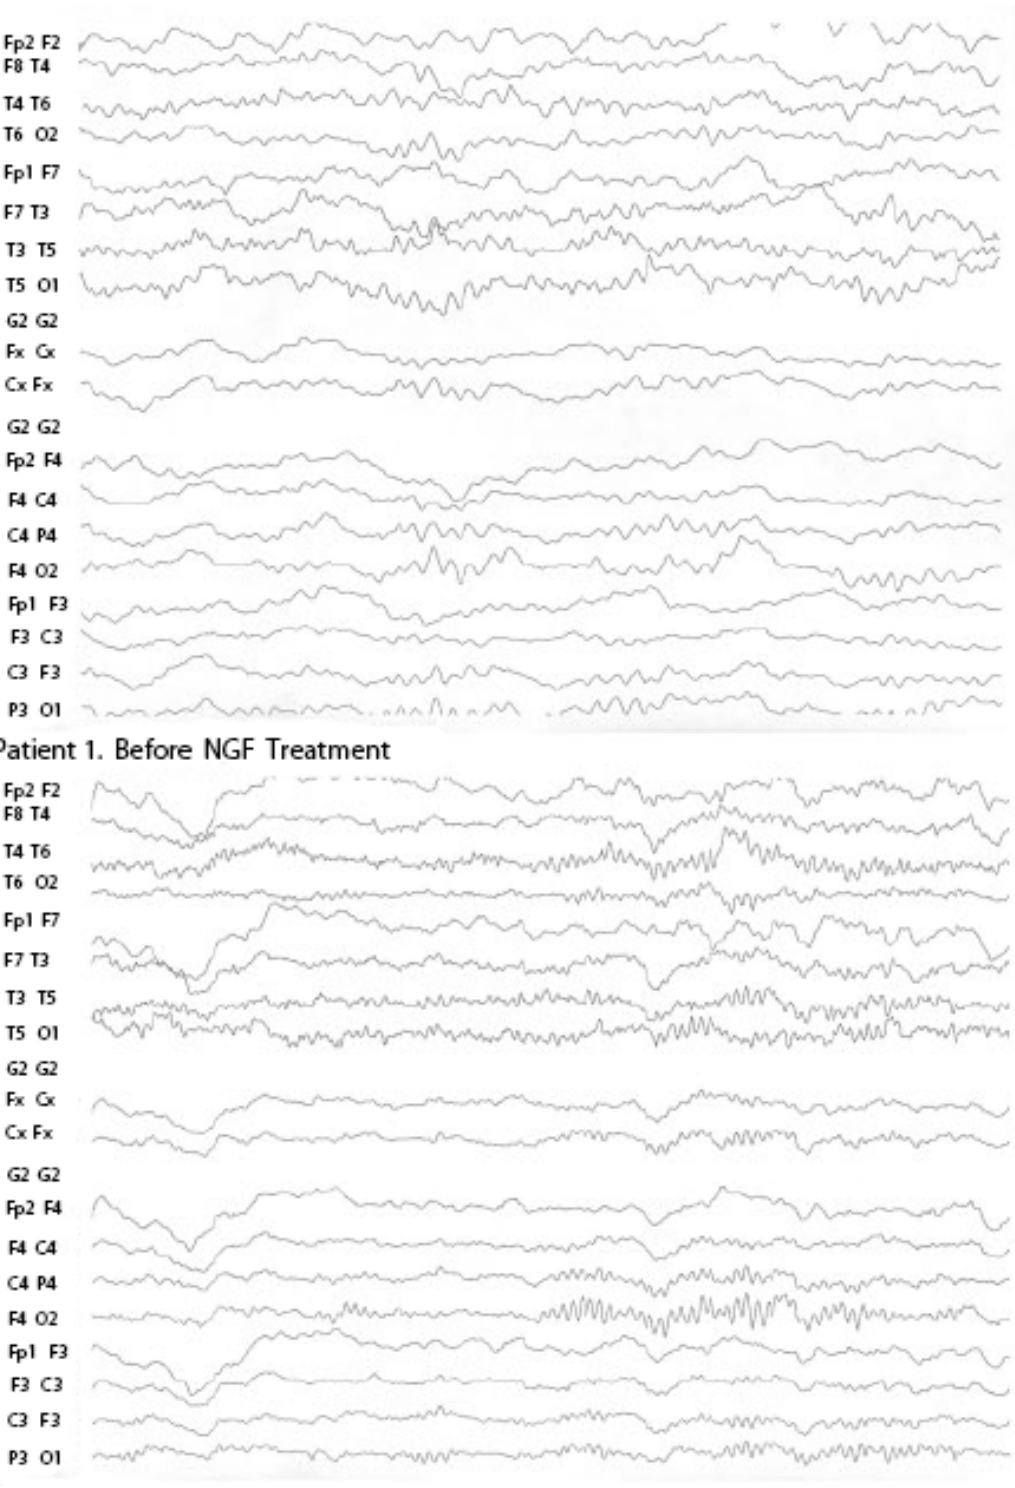
Figure 2. Serial electroencephalogram (EEG) examinations performed before and after the treatment with intraventricular Nerve Growth Factor (NGF) administration showed a constant and progressive reduction in slow-wave activity expressed as an increased alpha/theta ratio in both patients ( A ) patient 1; ( B ) patient